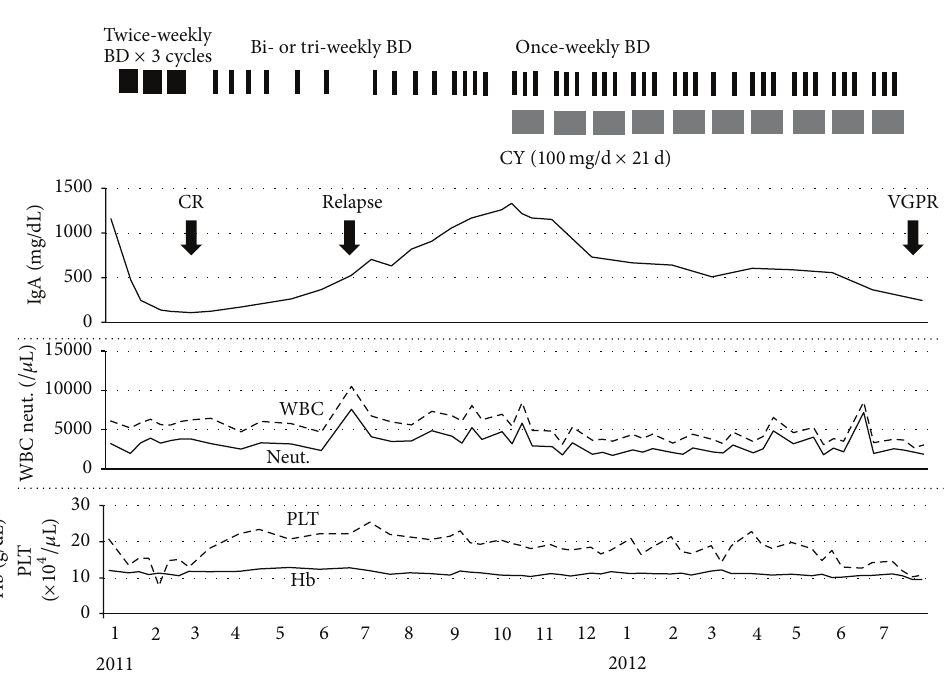
Figure 2: Clinical course of Case 2. BD: bortezomib plus dexamethasone; CY: cyclophosphamide; Hb: hemoglobin; PLT: platelet counts; WBC: white blood cell counts; and neut.: neutrophil